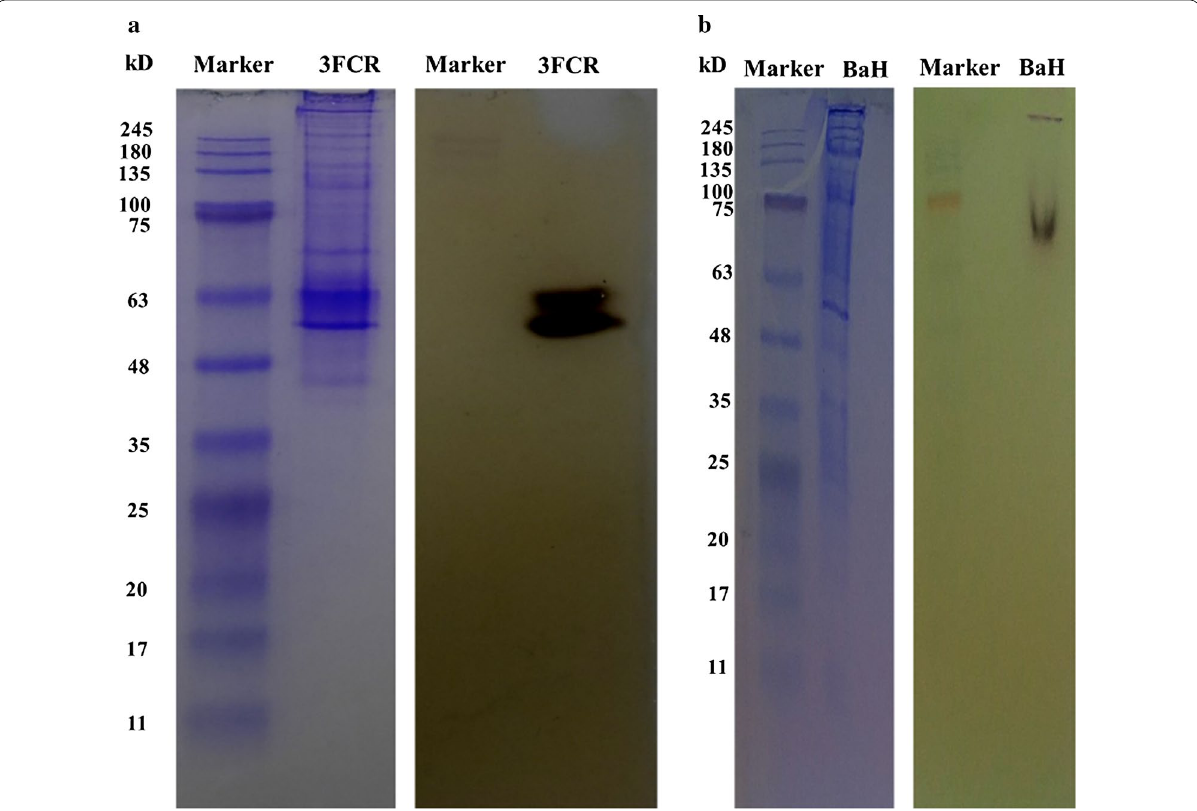
Fig. 5 Colorimetric assay for localization of ω-TAs on native polyacrylamide gel. Crude extracts of a 3FCR, overexpressed in E. coli . b Bacillus sp. strain BaH, each gel from left to right, containing Coomassie brilliant blue staining (as described in method section) and activity staining assay was carried out in 50 mM HEPES buffer, pH 7.5 with OXD (5 mM), pyruvate (7.5 mM) DMSO (5 %) and PLP (1 mM). The numbers indicating the protein marker bands resemble the order of the bands when used for SDS-PAGE according to the manufacturer’s manual and cannot be used for molecular weight determination in native gels. However, we used this pre-stained marker to demonstrate the color development and the specific staining of the ω-TA